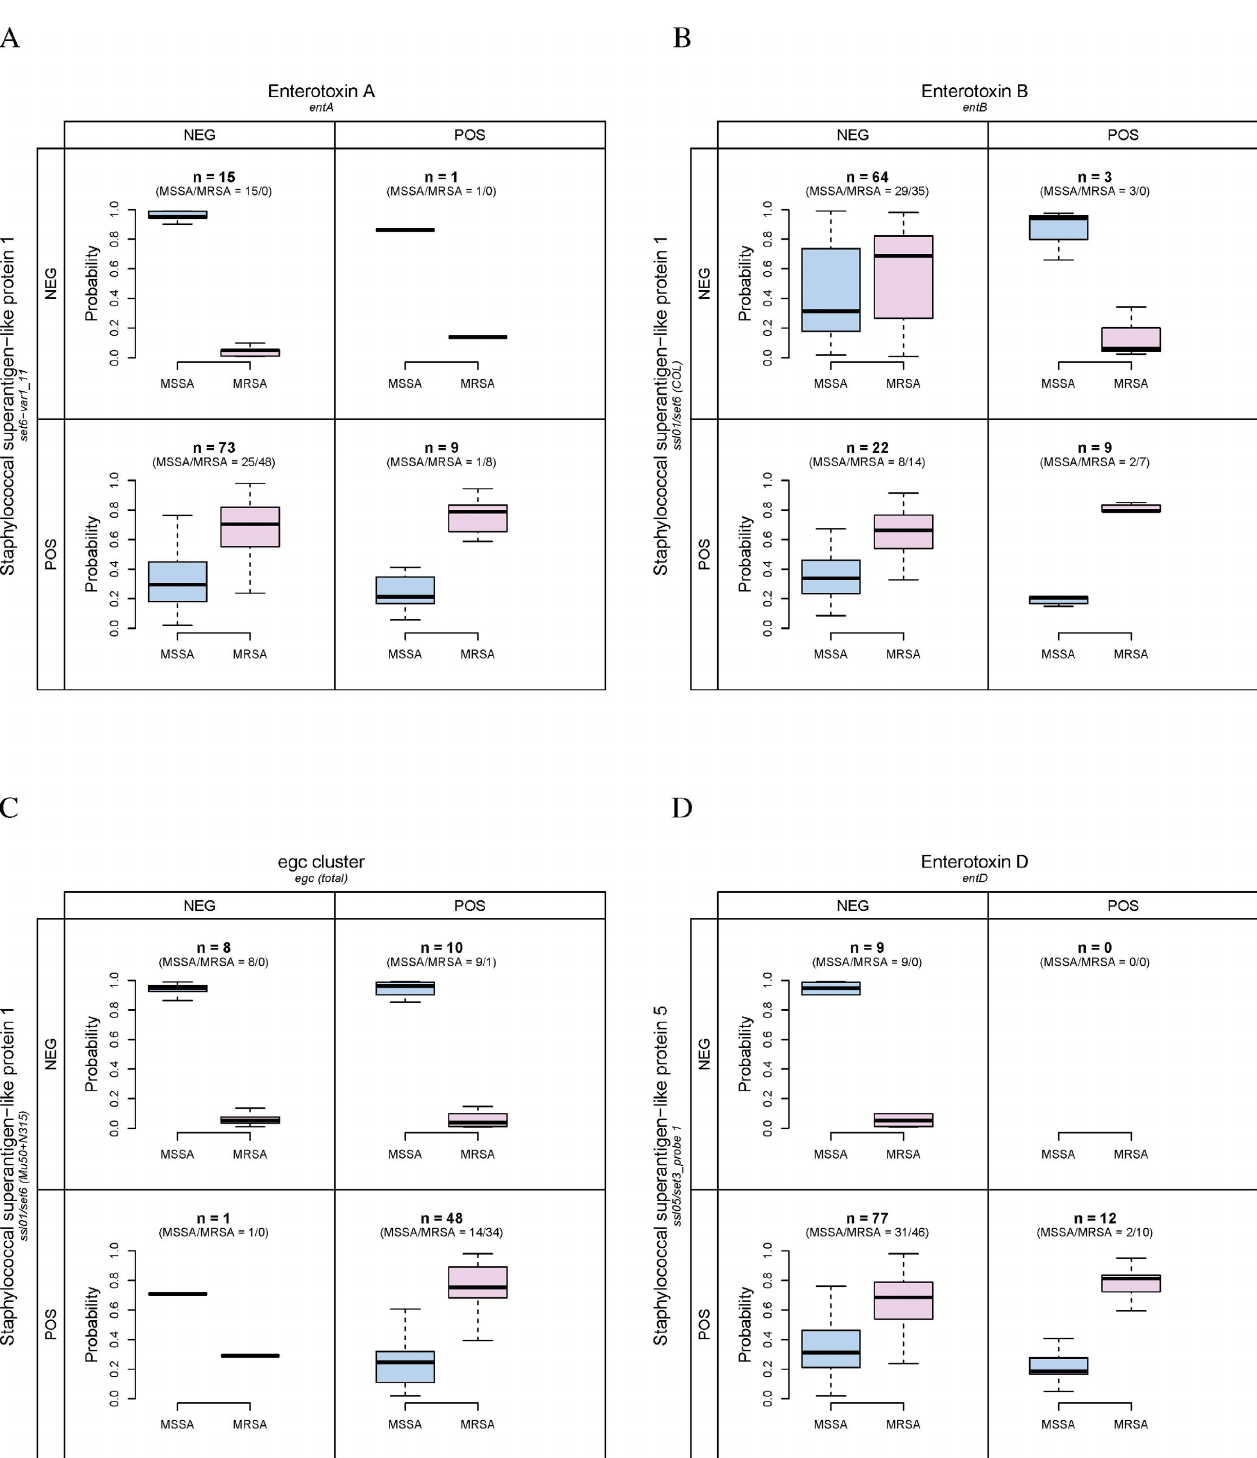
Fig 1. Random Forest estimated probabilities of MSSA and MRSA in terms of genotypic expression plotted against selected interactions between staphylococcal superantigens and enterotoxins. The numbers of detected MSSA and MRSA are listed in the parentheses. A: The interaction between entA and set6-var1_11 . B: The interaction between entB and ssl01/set6 (COL) . C: The interaction between egc (total) and ssl01/set6 (Mu50+N315) . D: The interaction between entD and ssl05/set3_probe 1 .